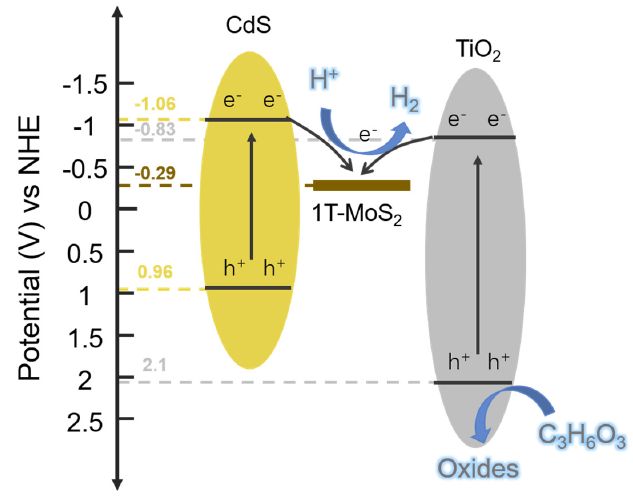
Figure 6. Schematic energy level diagram of CdS/1T-MoS 2 /TiO 2 ternary